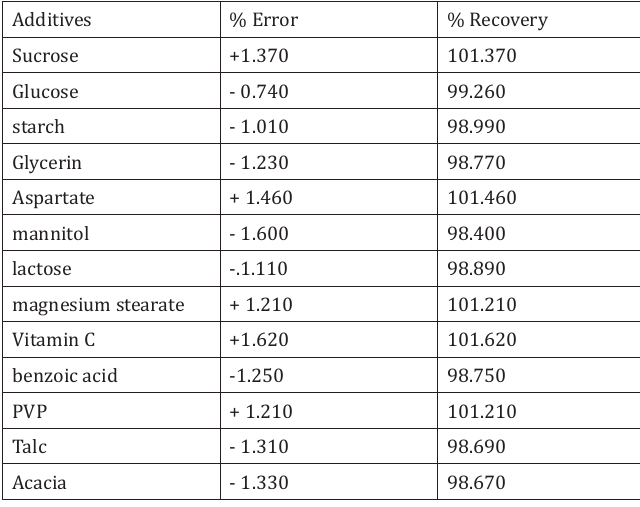
Estimations of VAN 20 ppm in the existence of